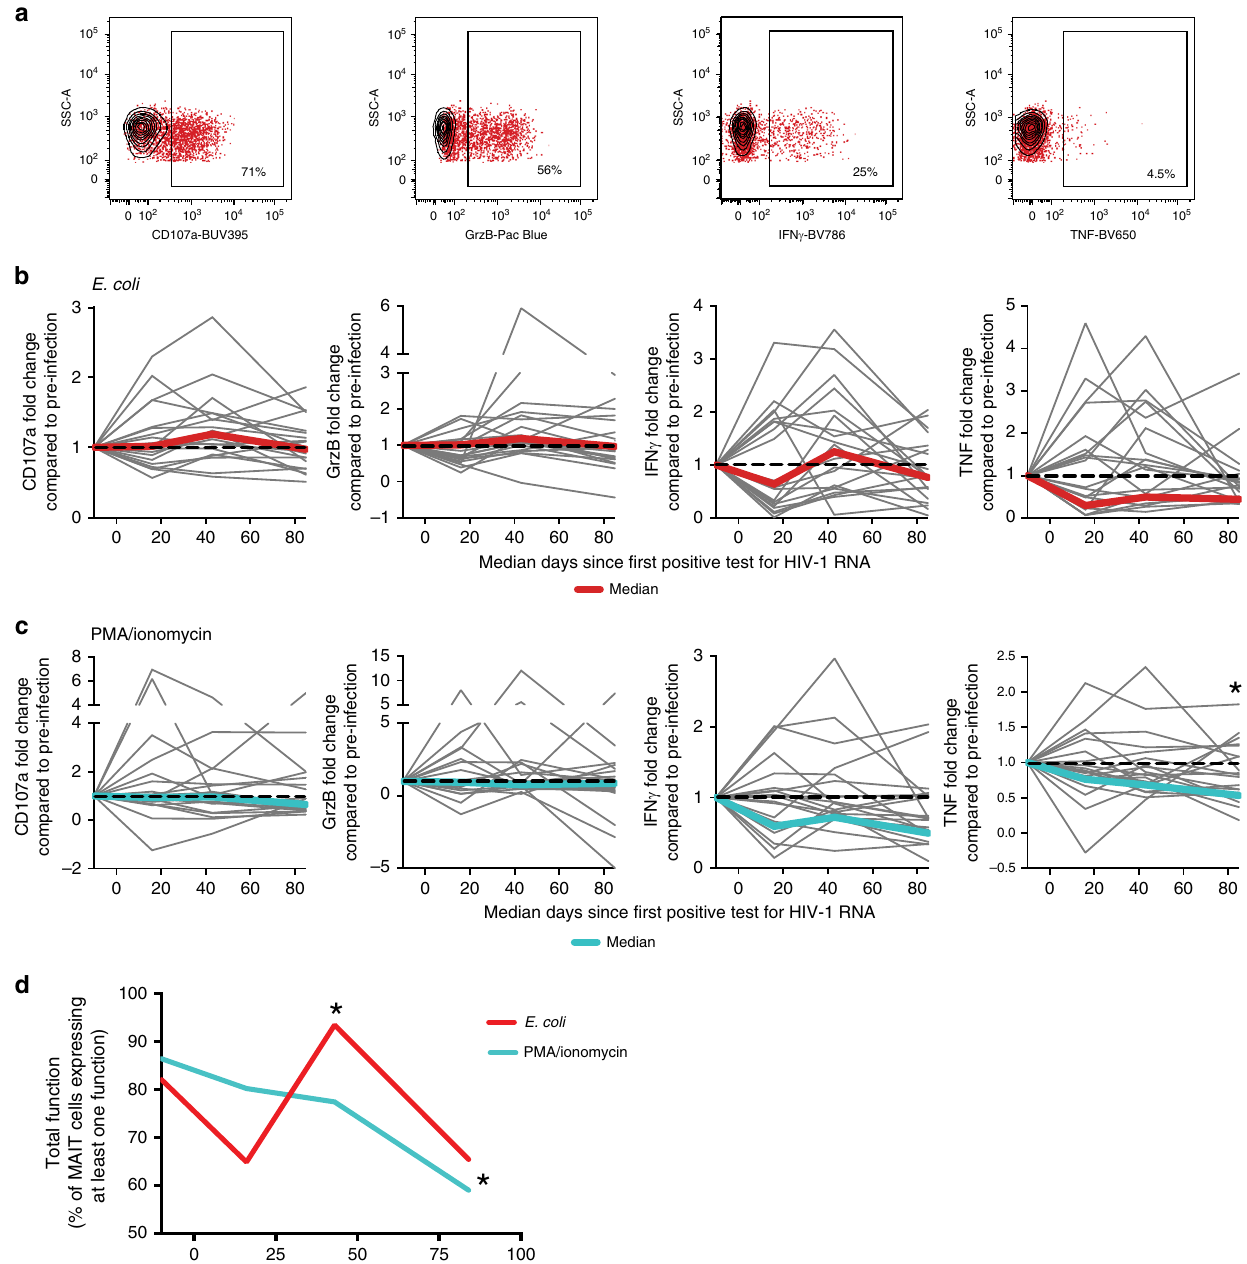
Fig. 6 MAIT cells in acute HIV-1 infection become dysfunctional in early chronic infection. PBMC from one pre-infection and three post-infection time points from the acute capture cohort study subjects ( n = 20) were stimulated with E. coli , PMA/ionomycin, or without stimulation, to examine expression of markers of cytotoxicity (CD107a and GrzB) and cytokine production (IFN γ and TNF) in MAIT cells. a Example fl ow cytometry gating showing the functional read out within the MAIT cell gate in unstimulated (black) and stimulated (red) cells. b MAIT cell functionality after stimulation with mildly fi xed E. coli , or c PMA/ionomycin is displayed longitudinally with data from one pre-infection and three post-infection time points in acute infection as the percentage of MAIT cells positive for functional markers, and the median of these markers at pre-infection is shown dashed black line. Longitudinal median values shown as a solid red or turquoise line, respectively. d The percentage of MAIT cells from b and c expressing at least one function is shown longitudinally. * p ≤ 0.05. In b, c , and d , statistical analysis was performed using the nonparametric Friedman test with the Dunn ’ s multiple comparison test. PBMC, Peripheral blood mononuclear cells. MAIT cells are identi fi ed as CD161 ++ V α 7.2 + cells within CD3 + CD14-CD19- live lymphocytes. VL viral load. The source data underlying d are provided as a Source Data fi